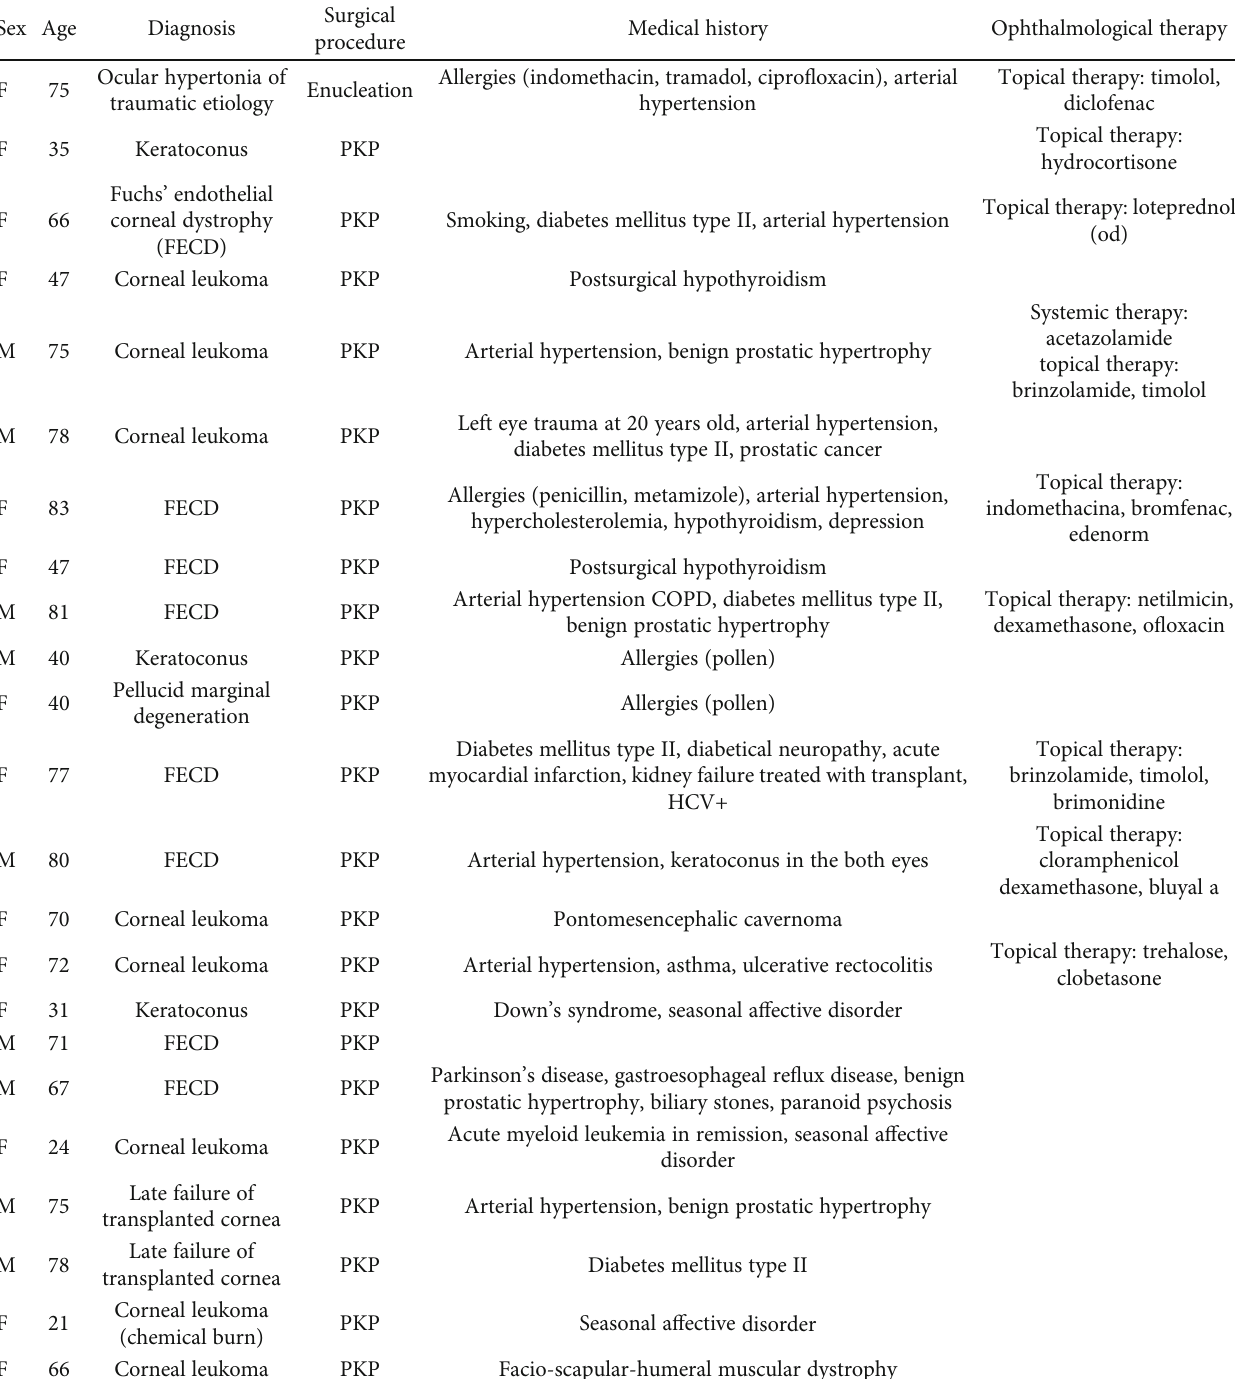
COPD: chronic obstructive pulmonary disease; FECD: Fuchs ’ endothelial corneal dystrophy; HCV: hepatitis C virus; PKP: penetrating